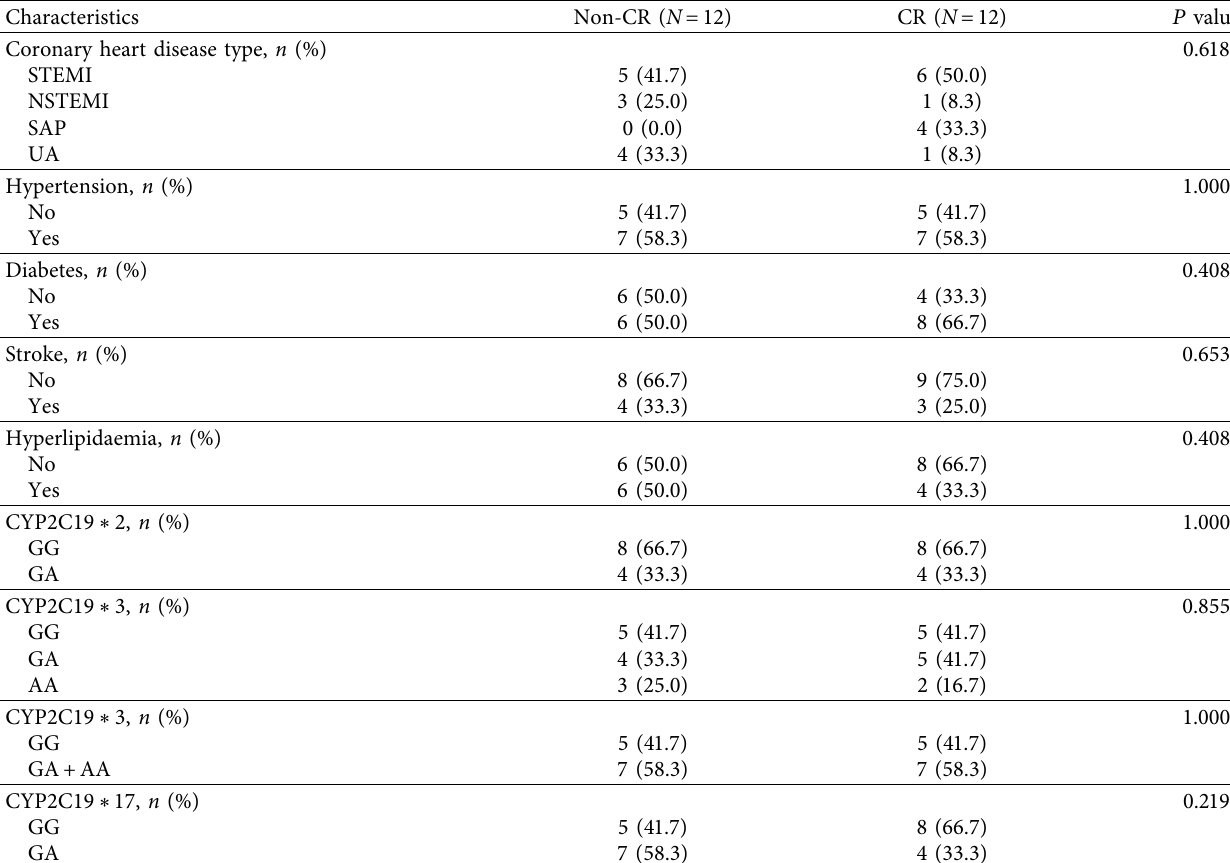
Table 5: Univariate and multivariate logistics regression analyses for CR in all participants.